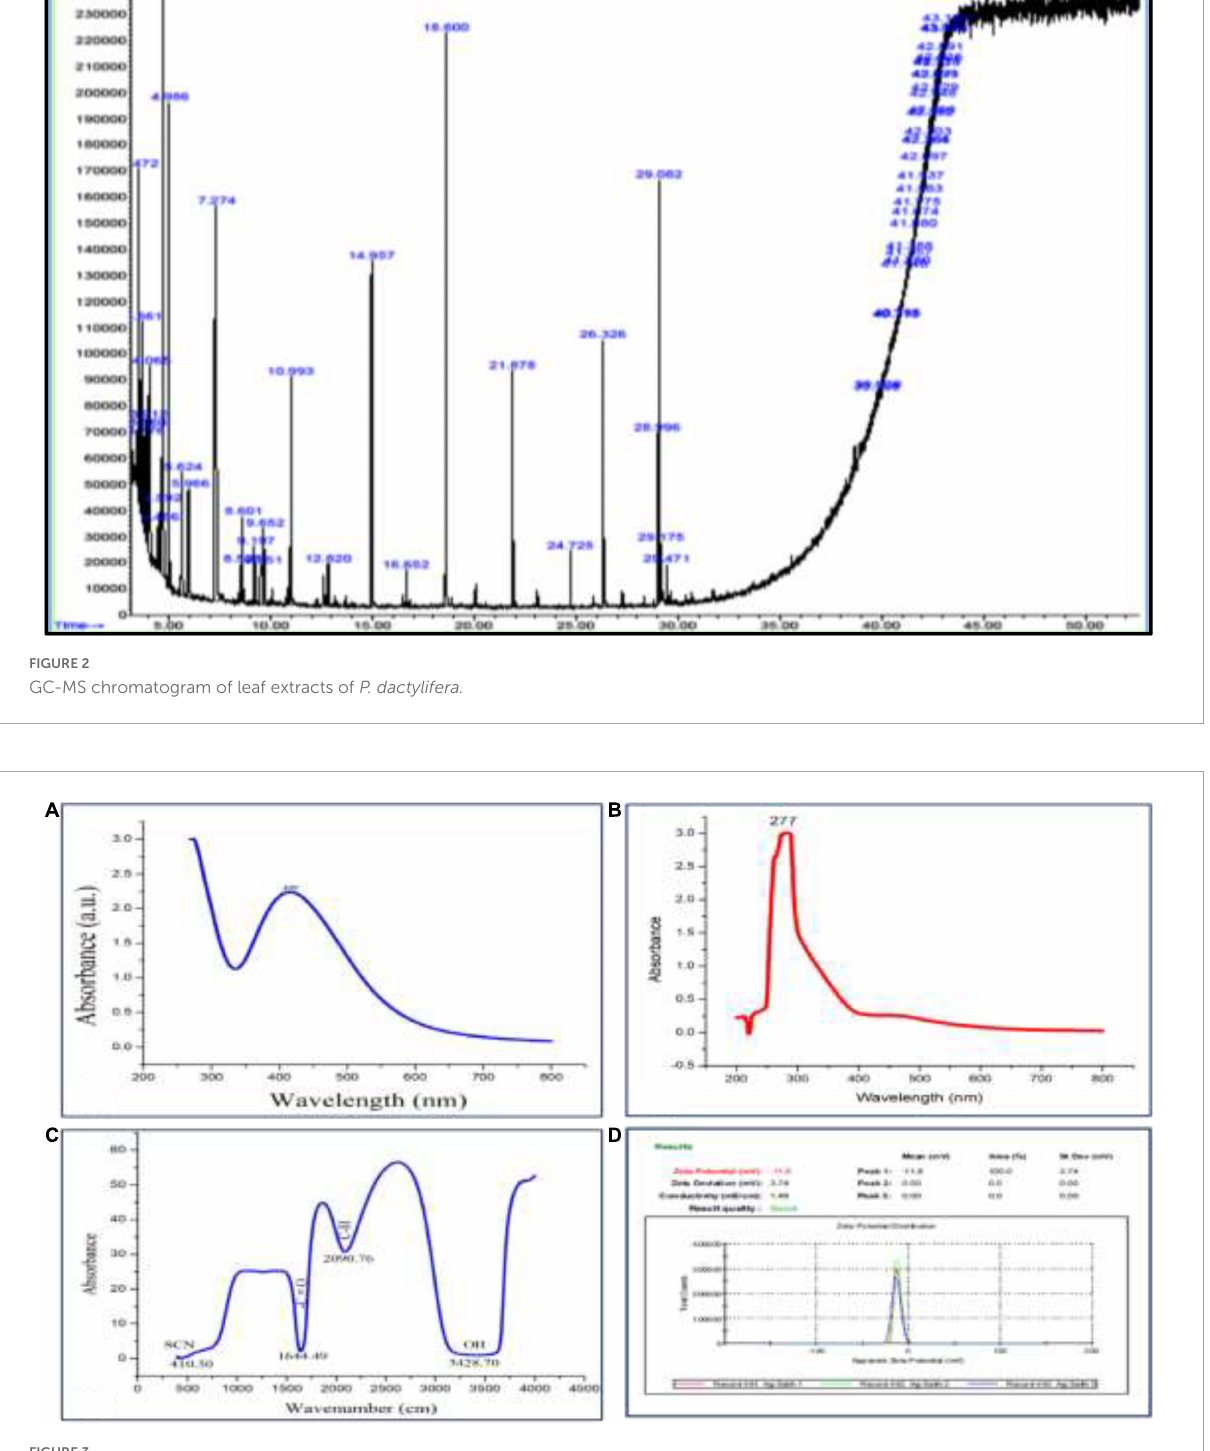
FIGURE3 (A) UV–Visible absorption spectrum of biogenic AgNPs, (B) UV spectrum of plant extract, (C) FTIR pattern of AgNPs, and (D) Zeta potential of